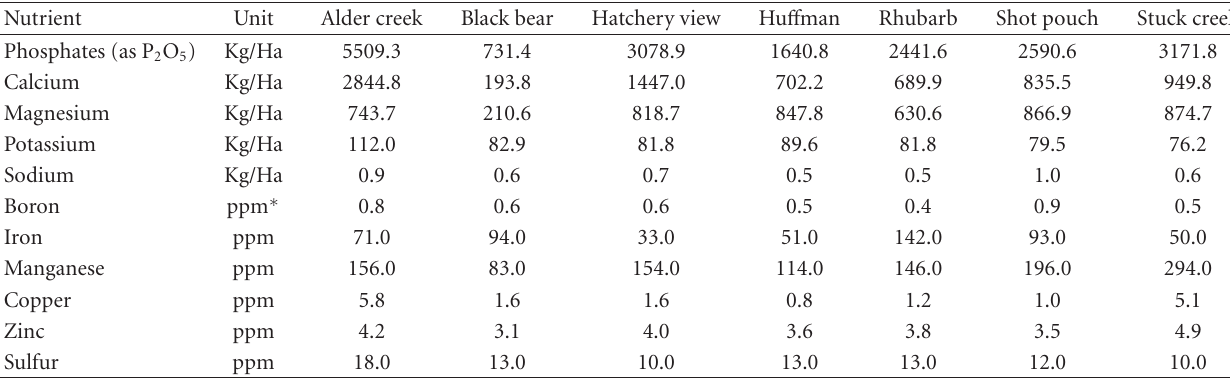
Table 2: Preexperimental soil chemistry determined at the seven study sites.